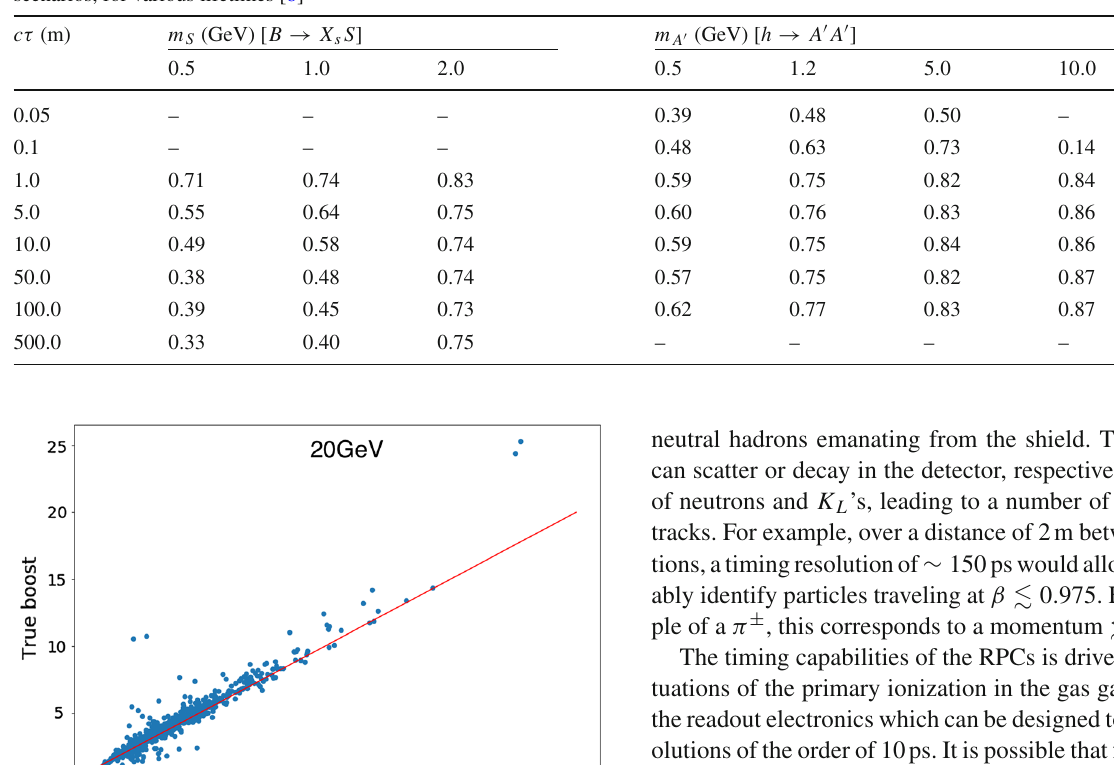
Table 7 Efficiency of reconstructing at least two tracks with the nominal design for both B → X s S (Sect. 2.3.2) and h → A (cid:3) A (cid:3) (Sect. 2.3.1) scenarios, for various lifetimes [8]